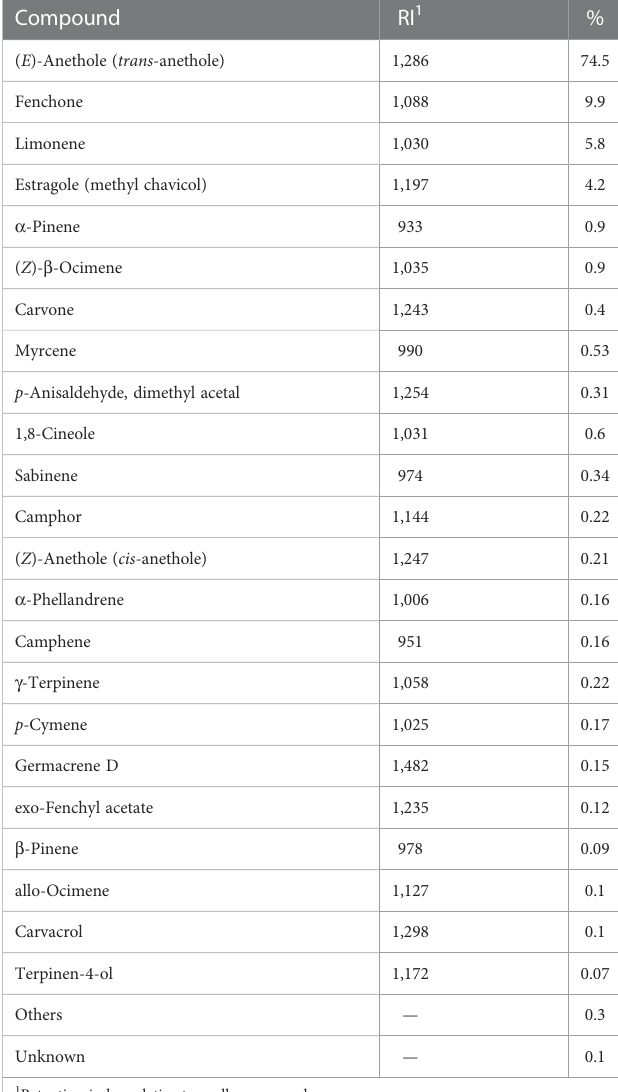
TABLE 1 Chemical components based on the total essential oil (%) distilled from fennel ( Foeniculum vulgare ) seed (n = 3)..